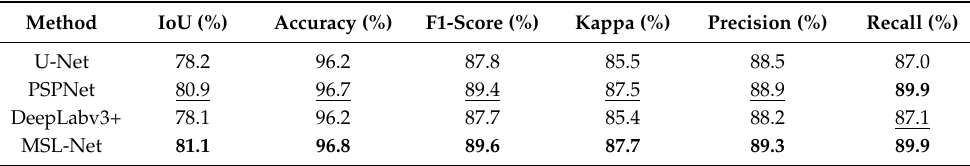
Table 6. Metrics produced on the Inria dataset. The highest scores are bolded; the second-highest scores are